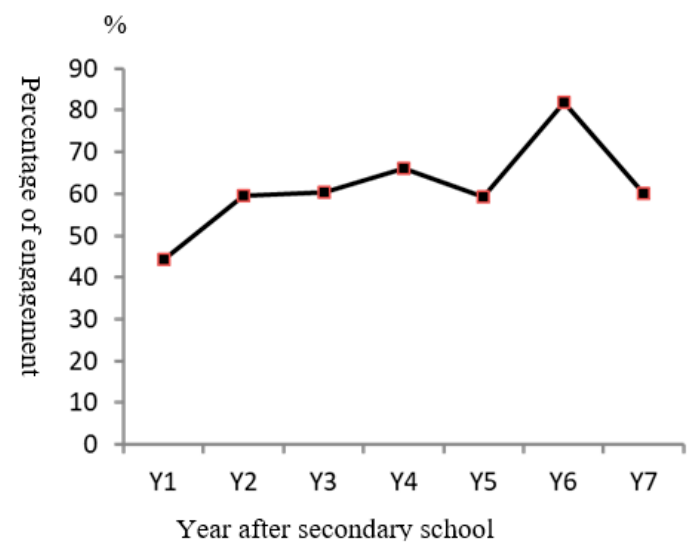
Figure 1. Level of employment engagement by duration of leaving secondary school.